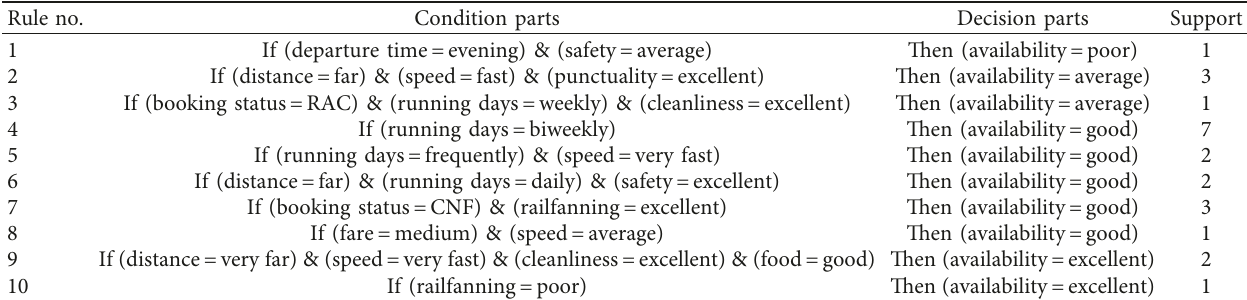
Table 5: Certain decision rules of the railway information system.